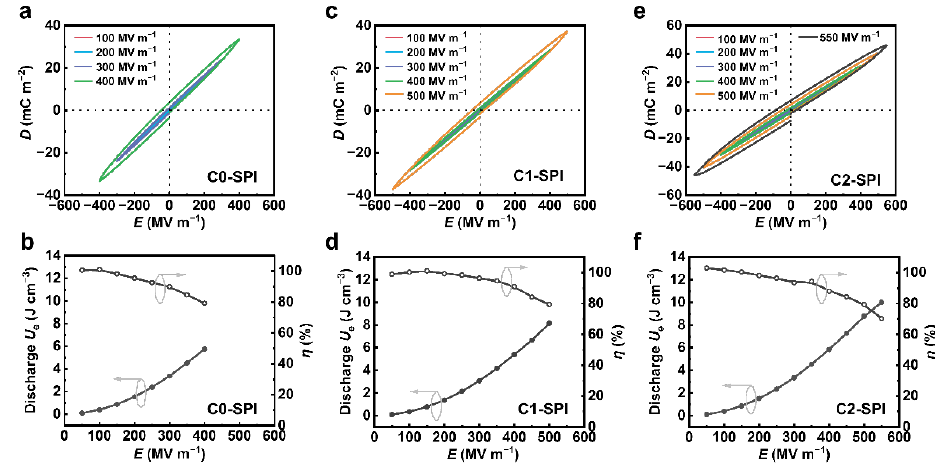
Figure 5. Bipolar D – E loops for ( a ) C0-SPI, ( c ) C1-SPI, and ( e ) C2-SPI, and corresponding discharged energy density ( U e ) and charge – discharge efficiencies ( η ) as a function of the poling field ( b , d , f ).